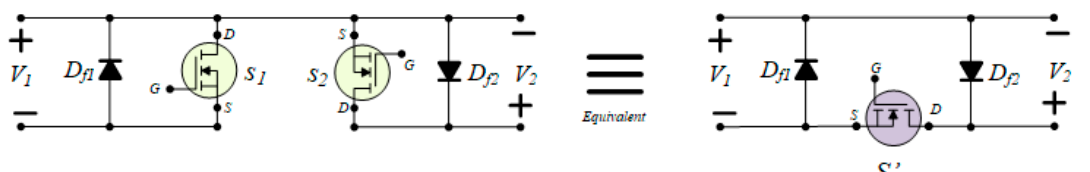
Figure 2. Restructured circuit for Figure 1 with a common node of drain ‐ source connection for the two switches.